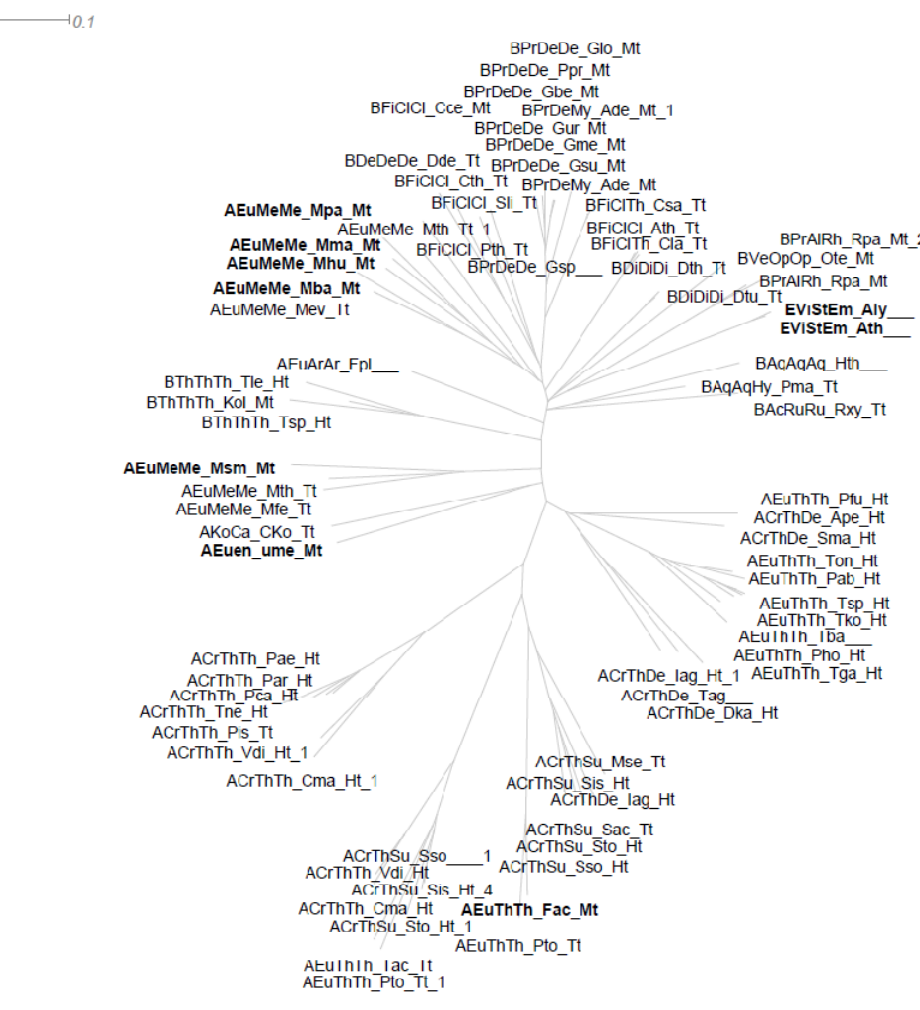
Fig. 1: A phylogeny of TrpB sequences. The sequences were collected by using BLAST and stored in a multiple fasta file. NCBI-labels were replaced by utilizing Key2Ann with the options superkingdom phylum class order temprange. The resulting file was processed by means of Jalview [15] and SplitsTree4 [17]. The first character of each label indicates the superkingdom (“E” Eukaryota, “B” Bacteria, “A” Archaea), the next two the phylum (e. g. “Cr” Crenarchaeota, “Eu” Euryarchaeota). The following infix gives the phylogenetic lineage (see Table 1) and the name of the species. E. g. the label AEuThTh_Pto_Tt indicates the lineage Archaea “A”, Euryarchaeota “Eu”, Thermoplasmata “Th”, Thermoplasmatales “Th”, and the species name Picrophilus torridus abbreviated as Pto. The ending “Tt” is one of the suffixes “Ht”, “Tt”, and “Mt” giving the growth temperature categorized according to hyperthermophilic, thermophilic, and mesophilic species. Missing data are indicated by a “__”. A number is added if the same label was generated for two sequences (e. g. for paralogous copies or subspecies). Labels for sequences from eukaryotic species (starting with an “E”) and of mesophilic Archaea (starting with an “A” and ending with an “Mt”) are printed bold; see text for details related to the position of these entries in the phylogenetic